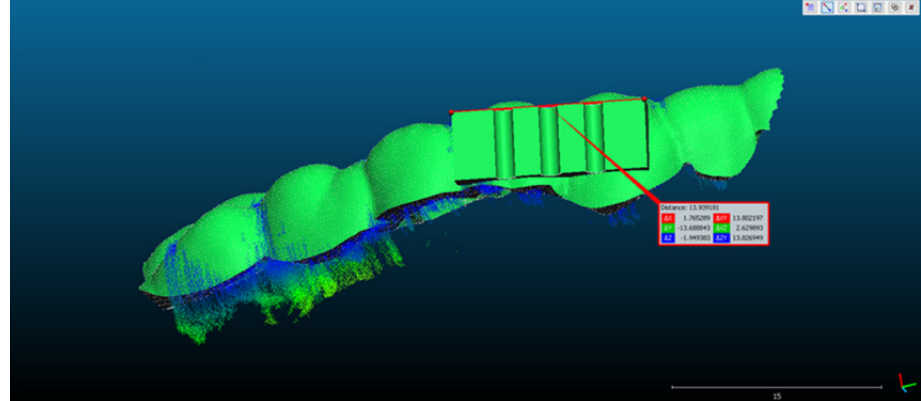
Figure 6. The scaling of the point cloud after it had been aligned with the reference object.